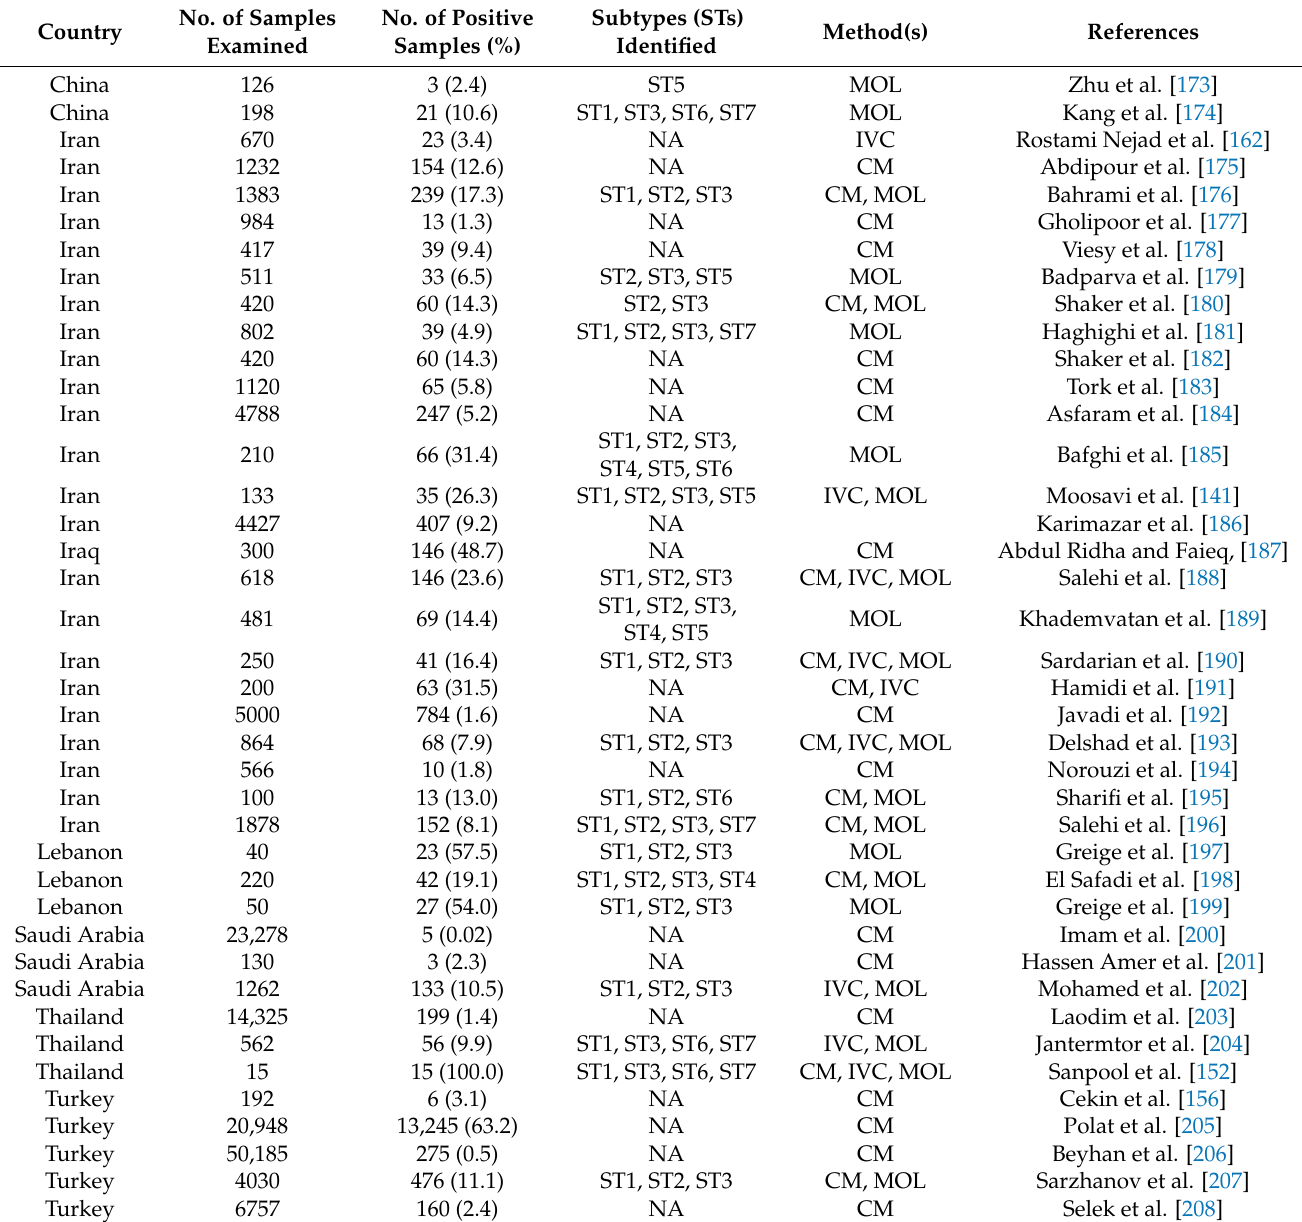
Table 5. Prevalence and subtype distribution of Blastocystis spp. in patients of health institutions in Asia (2010–2021) who volunteered in gastrointestinal studies.